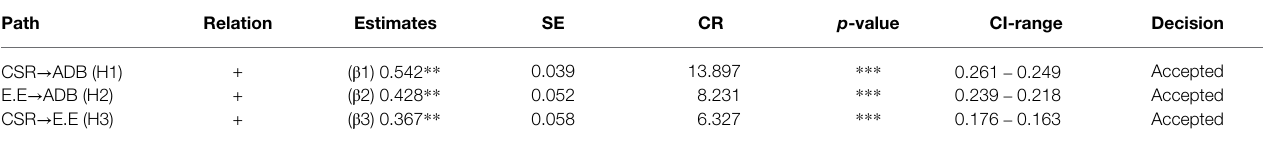
TABLE 7 | Outputs of direct effect model. Path Relation